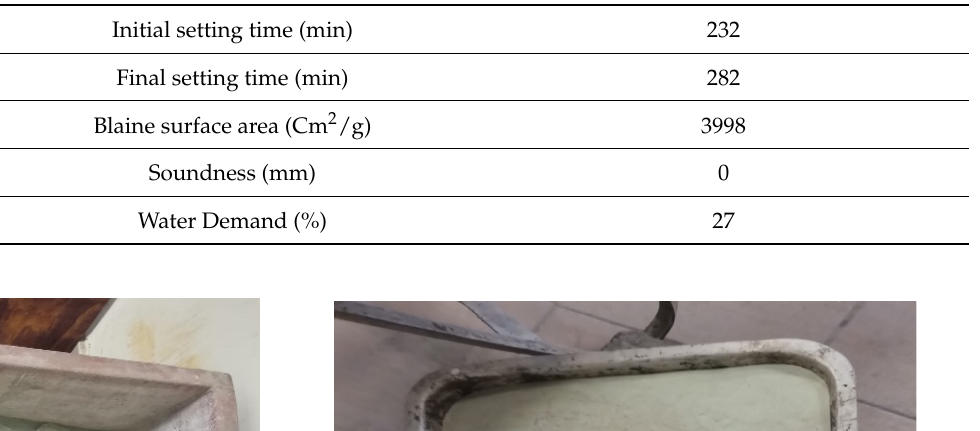
Table 2. Physical properties of cement.